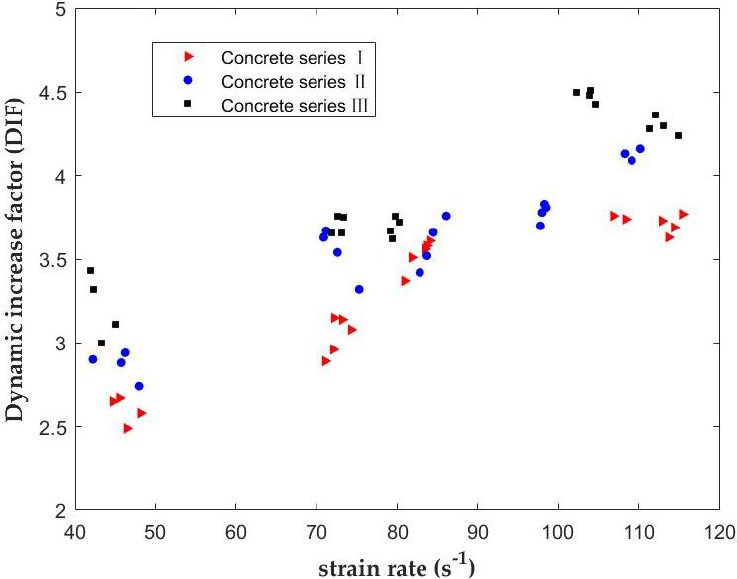
Figure 9. Relationship between the tensile DIF and the strain rate.